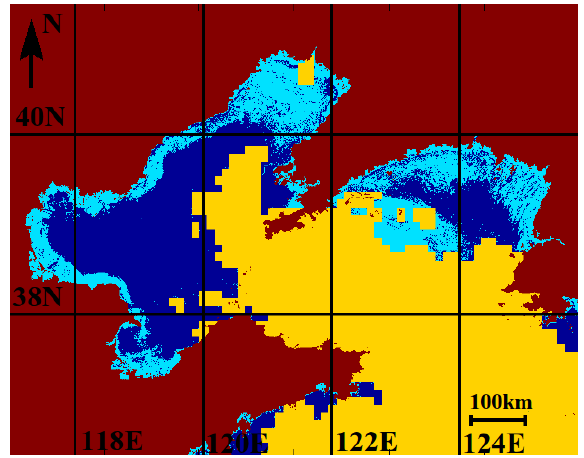
Figure 3. MODIS open-water-sea ice classification on 9 January 2013 using the ratio between MODIS bands 1 and 2 reflectances. Open-water = dark blue, sea ice = light blue, cloud mask = yellow, and land =